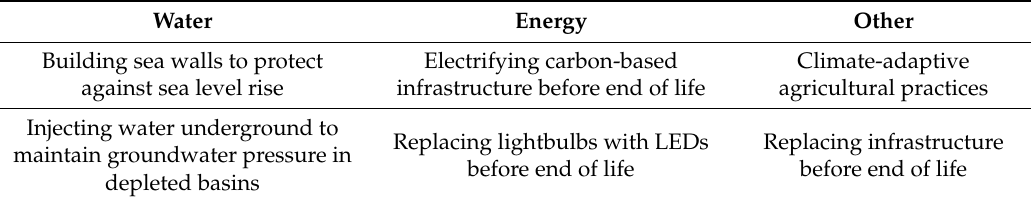
Table 2. Example applications for evaluation using mitigation LCA best